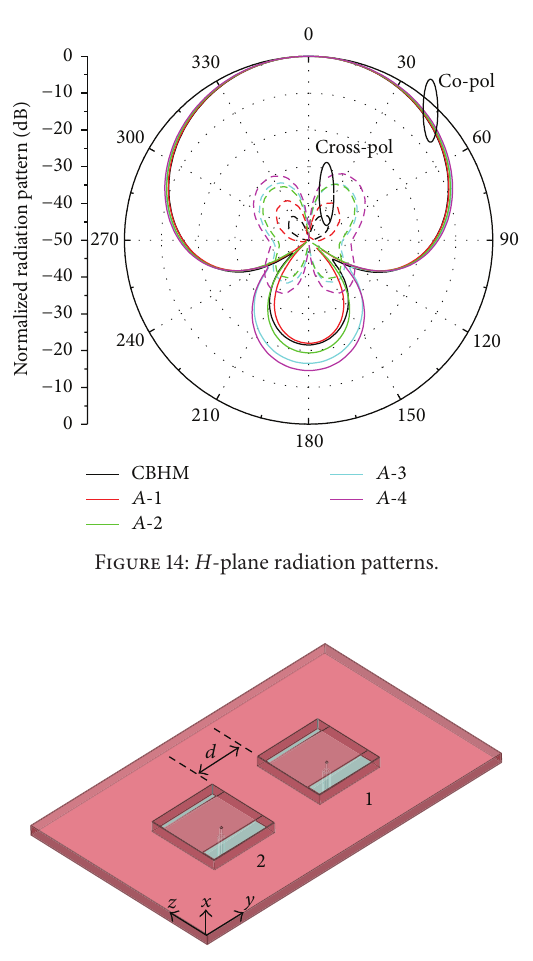
Figure 15: Side-by-side array of CBHM antennas.